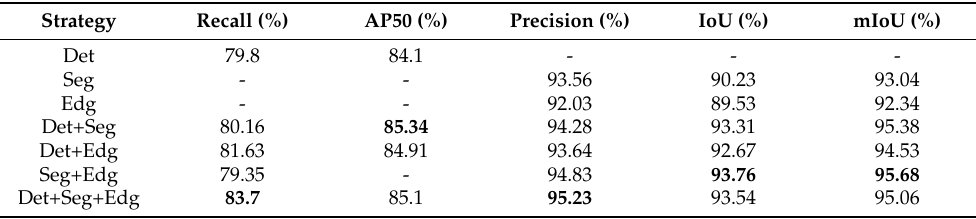
Table 9. Comparison between the multitask learning strategy and single-task learning strategy. Strategy Recall (%) AP50